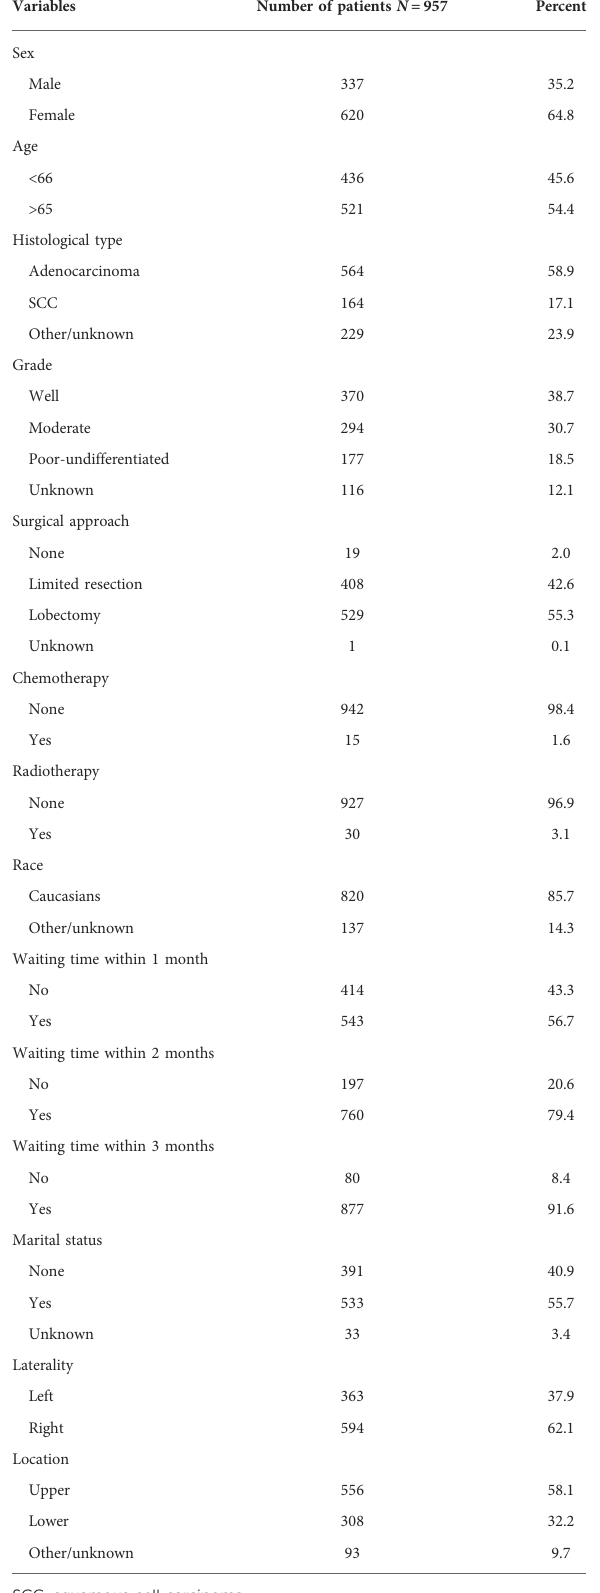
TABLE 1 The characteristics of patients in this